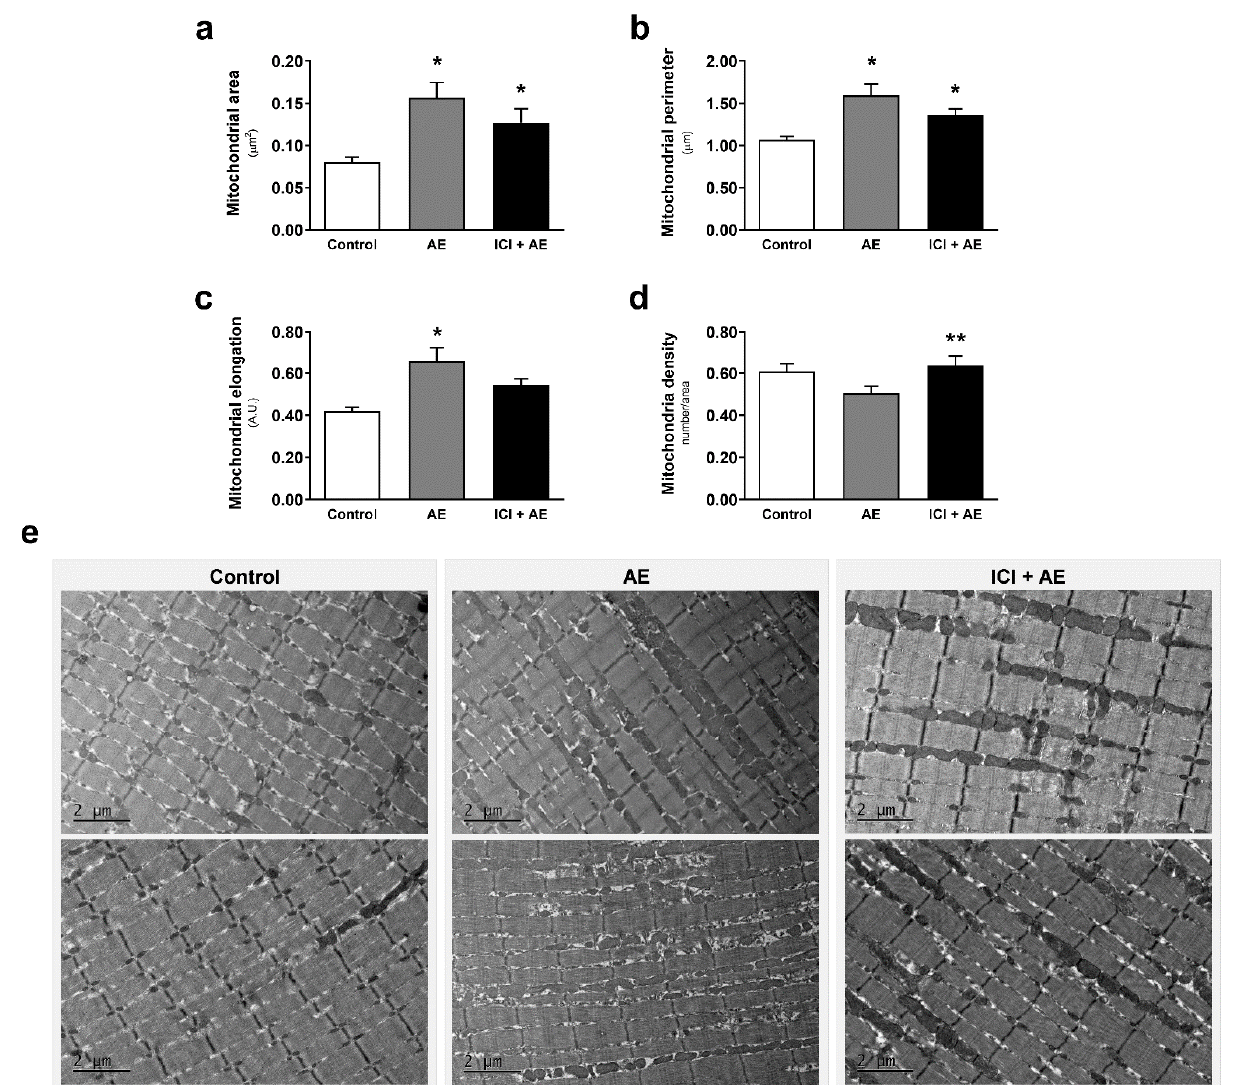
Figure 2. Skeletal muscle mitochondrial morphology is modulated by aerobic exercise, partially mediated by β 2 -ARs. Mitochondrial area ( a ), perimeter ( b ), elongation ( c ), mitochondria number per area ( d ), and electron microscopic representative images ( e ) of tibialis anterior muscle from exercised mice (single bout in a treadmill—80% of Vmax for 1 h, 5 ◦ inclination), with or without β 2 -AR blockade with ICI 118,551 (single dose—10 mg/kg, i.p., 30 min prior exercise). Data are presented as mean ± SE. * p < 0.05 vs. control and ** p < 0.05 vs. AE. n =